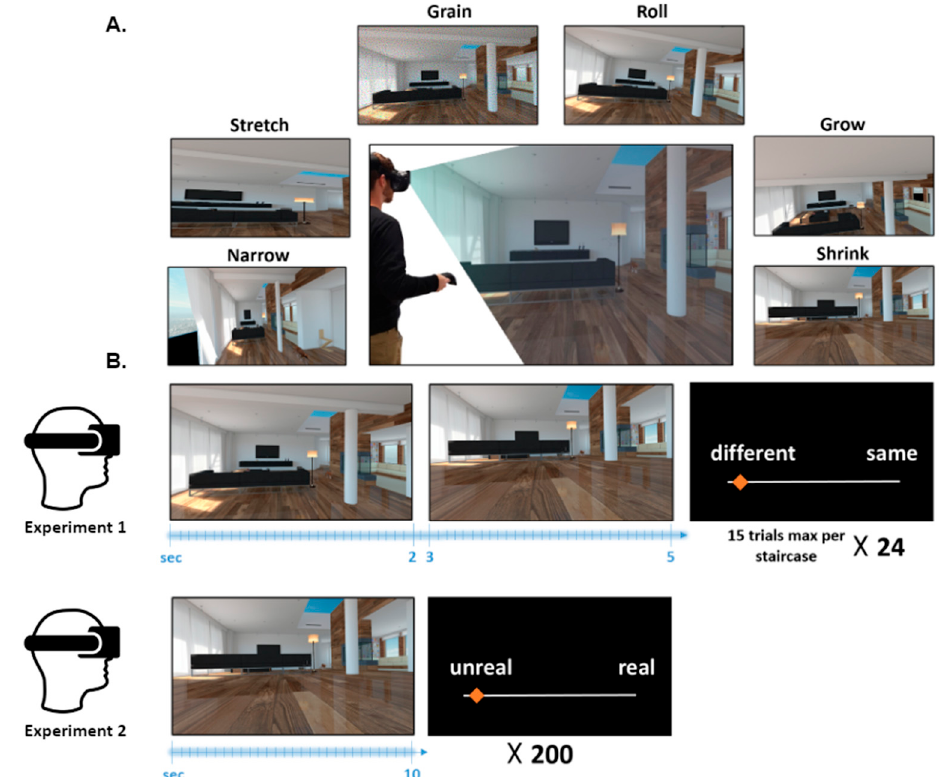
Figure 1. Experimental setup and design. ( A ) Center, illustrative image of the experimental setup and visual scenario. Participants donned a head-mounted display (HMD) and viewed the immersive virtual environment in 360 ◦ around them. The images on the sides and bottom represent the six types of alterations of the visual aspects employed, at the highest magnitude of alteration shown, for comparison, on a similar section of the virtual room. ( B ) Trial flow for the experiments. (Top) In Experiment 1, a virtual reality (VR) environment appeared for 2 s, followed by a black screen and then a second VR environment. Subsequently, participants were presented a question screen asking them to report if the two VR environments were identical or not. (Bottom). In Experiment 2, participants viewed a VR environment, which could be altered or unaltered. In each trial, they were required to judge on a continuous scale how ‘real’ the environment felt to them.